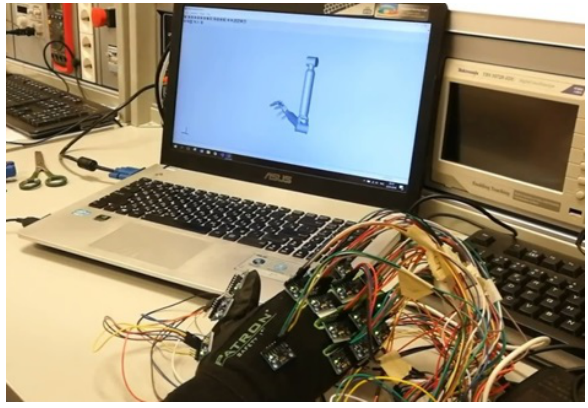
Figure 10: Glove interacted with virtual robot.